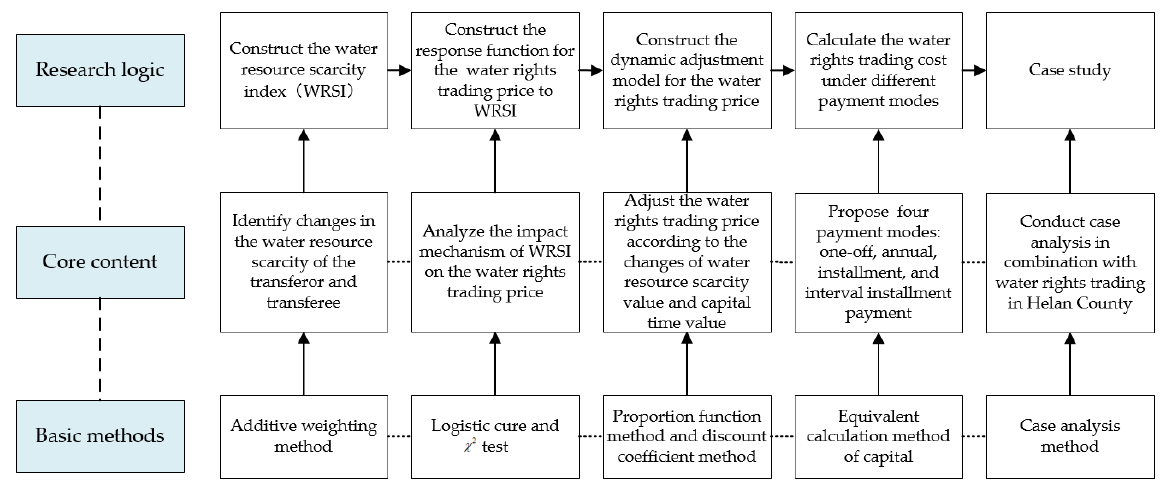
Figure 1. The basic idea of the study.